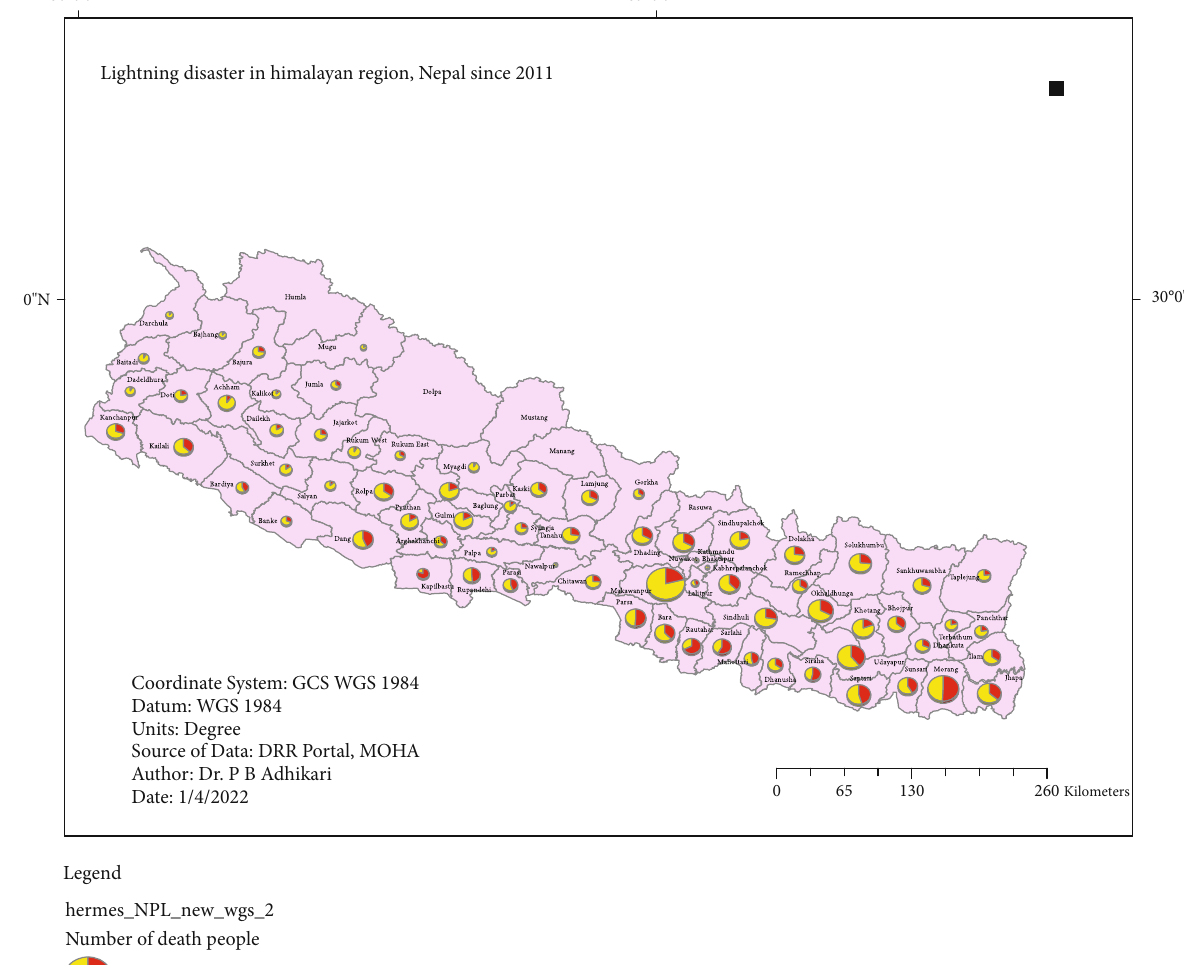
Figure 6: The representation of the death of the people and the number of injured people due to lightning are proportionally represented in the diagram and the size of the pie diagram represents the number of lightning